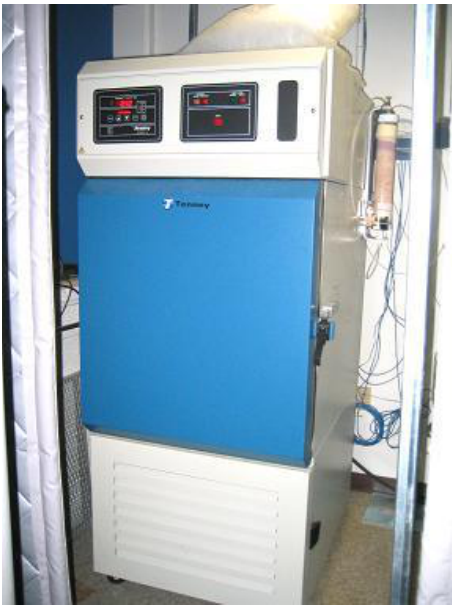
Figure 1. Environmental chamber (model: Tenny T10RC-1.5 SPL) (Tenny Engineering, 1090 SPRINGFIELD RD, Union, NJ 07083, United States).